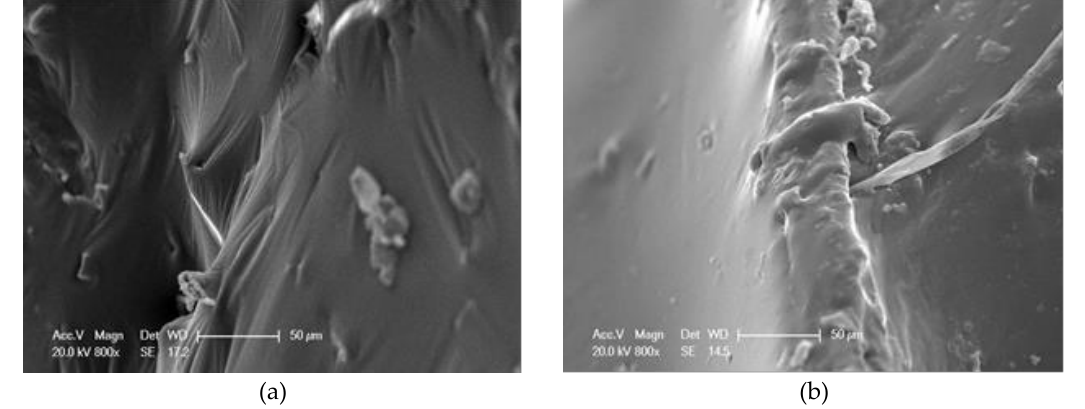
Figure 16. Micro images of MFRA (0:3): ( a ) image 1, 800×; ( b ) image 2, 800×.